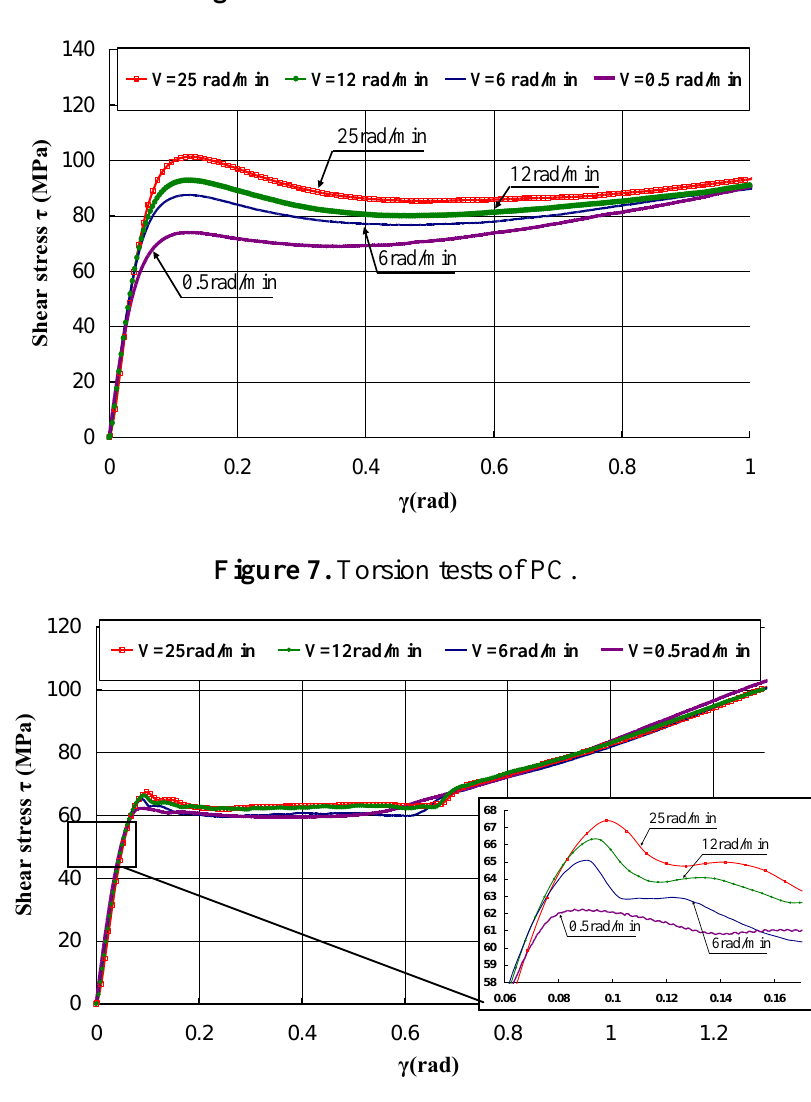
Figure 6. Torsion tests of PMMA.